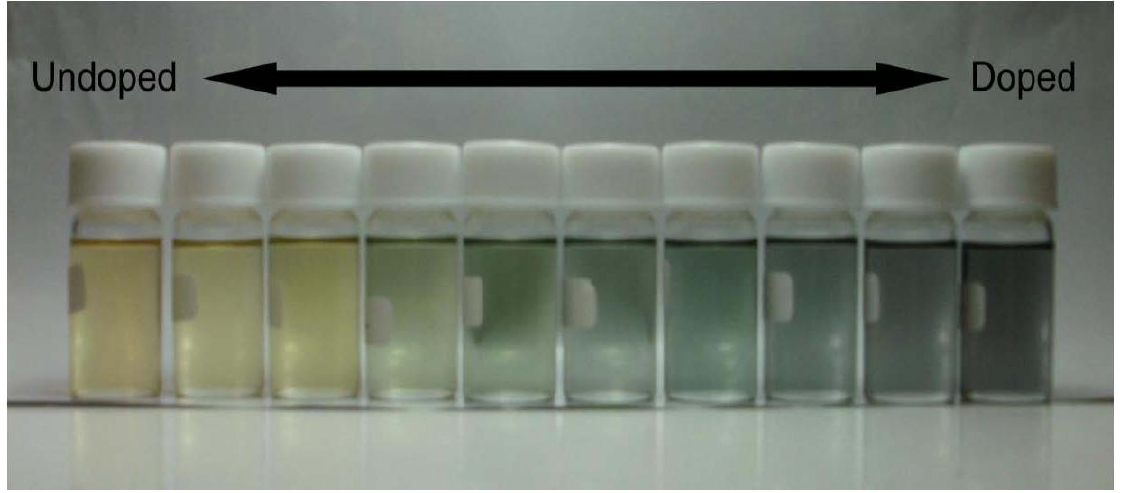
Figure 5. Color change of ME1 in CHCl